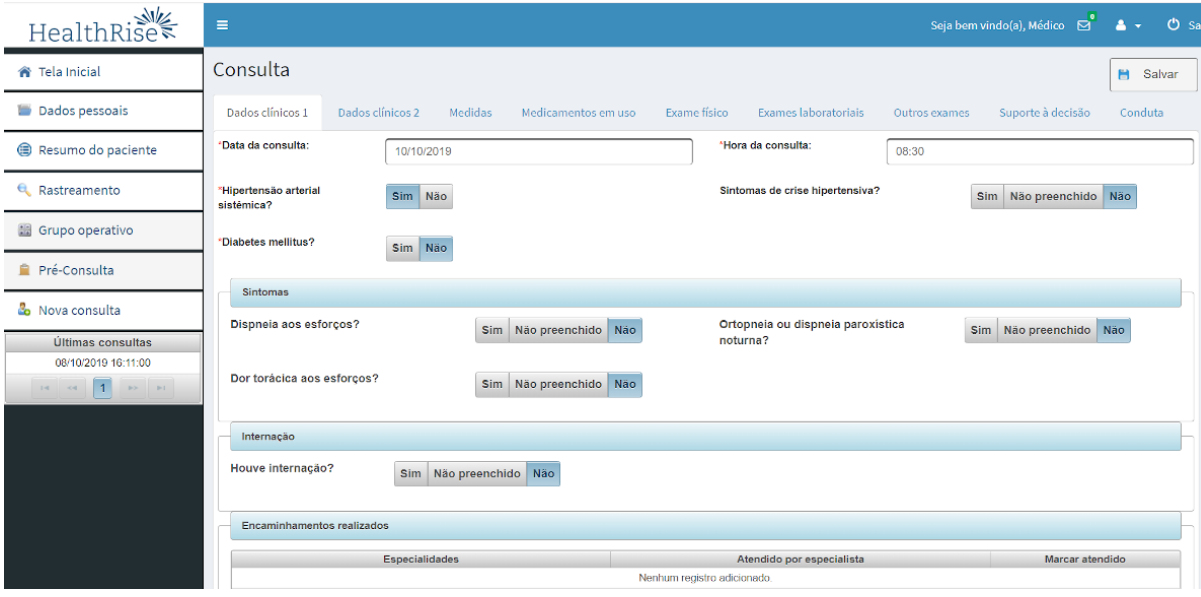
Figure 3. Structured clinical